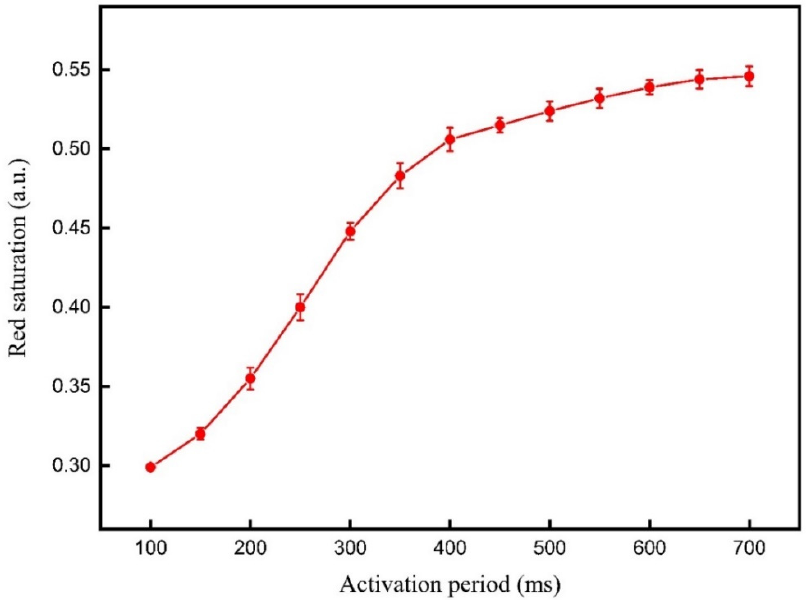
Figure 8. The red saturation achieved by different activation stages of the traditional driving waveform. The red saturation increased with the increase of the activation period, and then it tended to saturation when the activation period reached 650 ms.